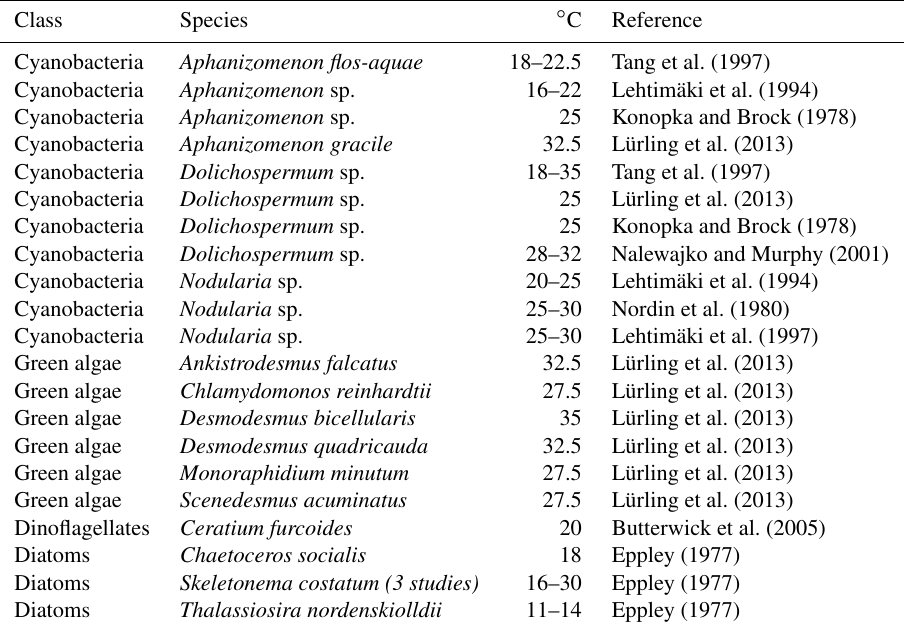
Table 7. Optimal temperature ranges for growth of different phytoplankton